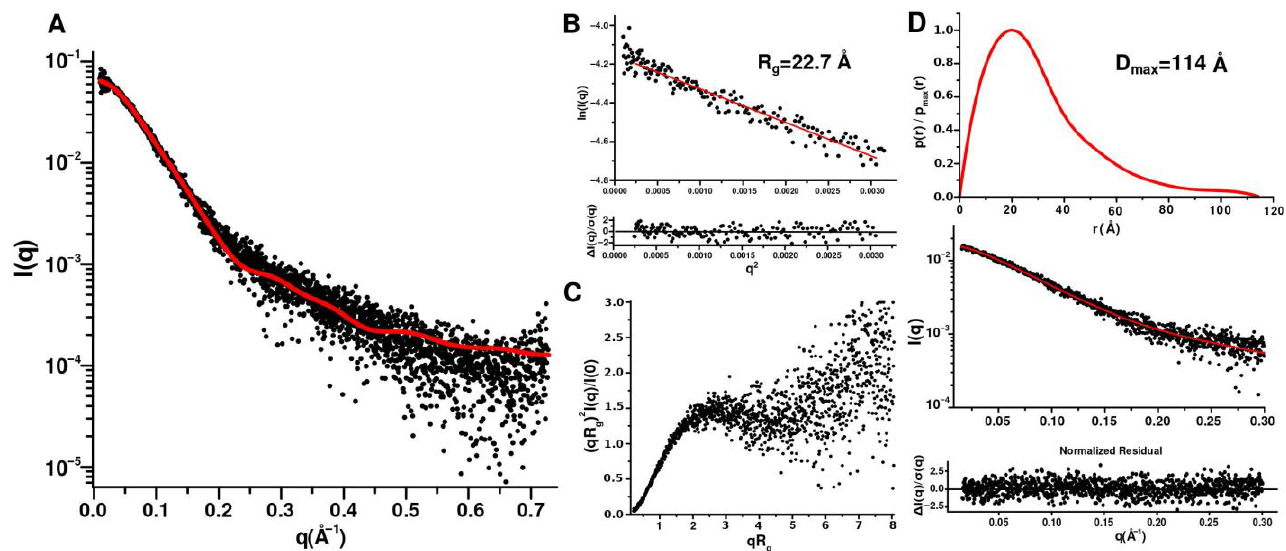
Figure 5. Analysis of SAXS data for oxidized CytC552. The measurements were carried out at 20 °C in 50 mM sodium phosphate buffer with pH 7.5. ( A ) Experimental SAXS profile (black circles) and theoretical curve (solid red line) calculated for the NMR structure of CytC552 using FOXS program. ( B ) Guinier plot with linear fit (red solid line). ( C ) Dimensionless Kratky plot. ( D ) Pair-distance distribution function profile with fitting curve (GNOM).